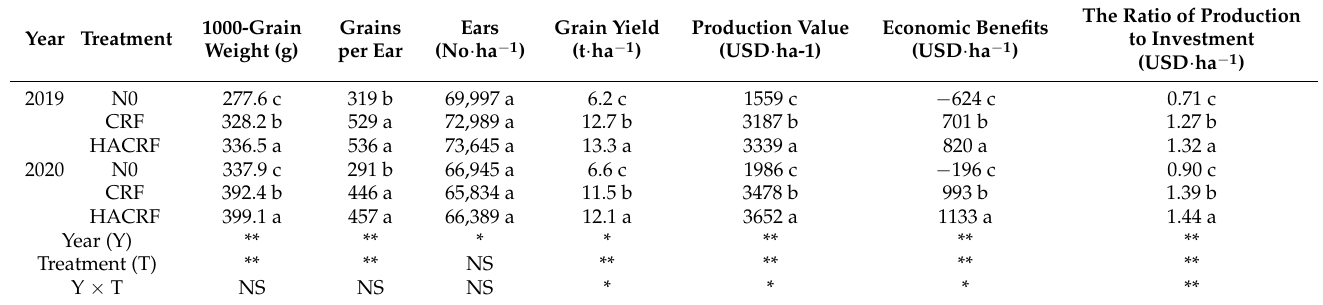
Table 1. Effects of humic acid added to controlled-release fertilizer on the yield and production values of summer